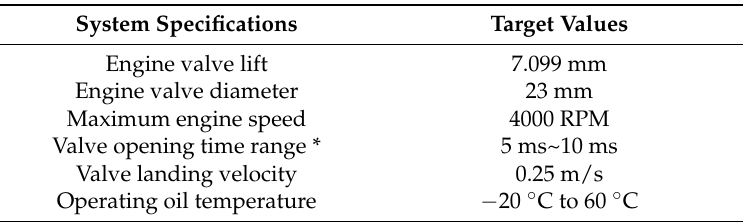
Table 1. Design parameters and target